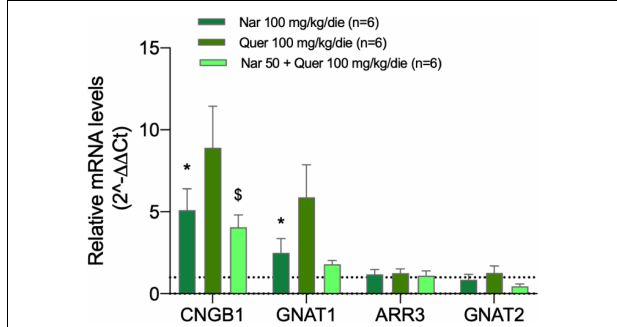
FIGURE 4 | Transcriptional levels of photoreceptor genes from the treated groups of animals compared to the pathological control. The transcriptional levels of four mRNAs coding for photoreceptor proteins were analyzed by real-time PCR. Specifically, the histogram shows the expression of CNBG1 coding light-sensitive channel, GNAT1 coding transducin 1, ARR3 coding cone-arrestin, and GNAT2 coding transducin 2 in the control group (DMSO treated animals) and in groups treated with naringenin 100 mg/kg/day, quercetin 100 mg/kg/day, and naringenin 50 + quercetin 100 mg/kg/day ( n = 6, respectively). The data are representative of six animals ± SEM. The bars represent the value obtained after normalization of each value on the mean expression of the most stable genes among those analyzed (from array data) and are expressed as fold-change relative to the control group (made = 1). The statistical analysis was performed using Student’s t -test of the normalized values for each gene in treatment groups (* p ≤ 0.05, naringenin 100 group vs. DMSO group; $ p ≤ 0.05, naringenin 50 + quercetin 100 group vs. DMSO group).